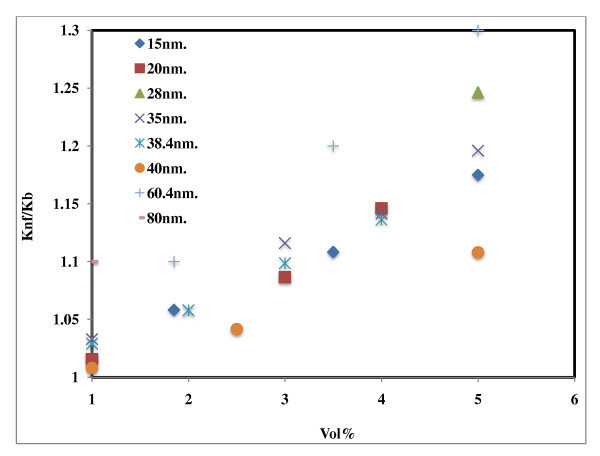
Effect of particle size on thermal conductivity of ethylene glycol-based Al2O3 nanofluids. 15 nm [16], 20 nm [11], 28 nm [8], 35 nm [18], 38.4 nm [1], 40 nm [14], 60.4 nm [16], 80 nm [20].